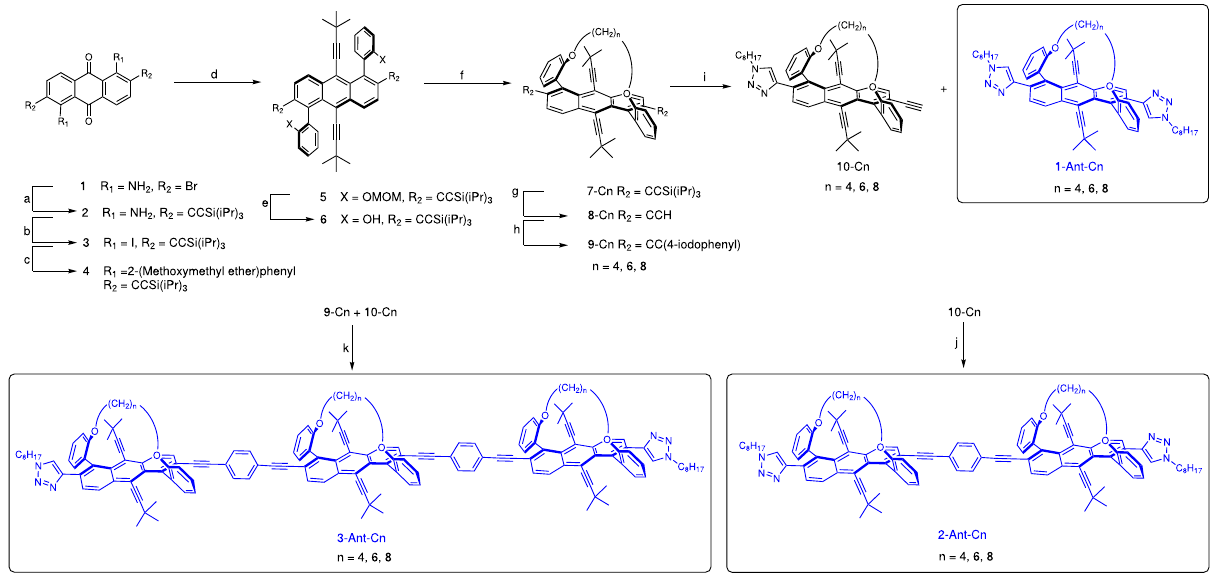
Fig. 2 Synthesis of twistacene monomer (1-Ant-Cn), dimer (2-Ant-Cn), and trimer (3-Ant-Cn). a HCCSi( i Pr) 3 , Pd(PPh 3 ) 2 Cl 2 (0.1 equiv.), CuI (0.05 equiv.), THF/Et 3 N (2:1), re fl ux. b NaNO 2 , H 2 SO 4 , KI. c 2-(Methoxymethyl ether)phenylboronic acid, Pd(PPh 3 ) 4 , dioxane/water (4/1), 94 °C, 5 d; d (1) (CH 3 ) 3 CCH, n-BuLi, THF, 0 °C → rt, 10 h; (2) SnCl 2 , THF, 4 h; e dil. HCl, 40 °C, 16 h. f Br-(CH 2 ) n -Br, K 2 CO 3 , DMF, 40 – 60 °C n = 4, 6, 8; g TBAF, THF, 0